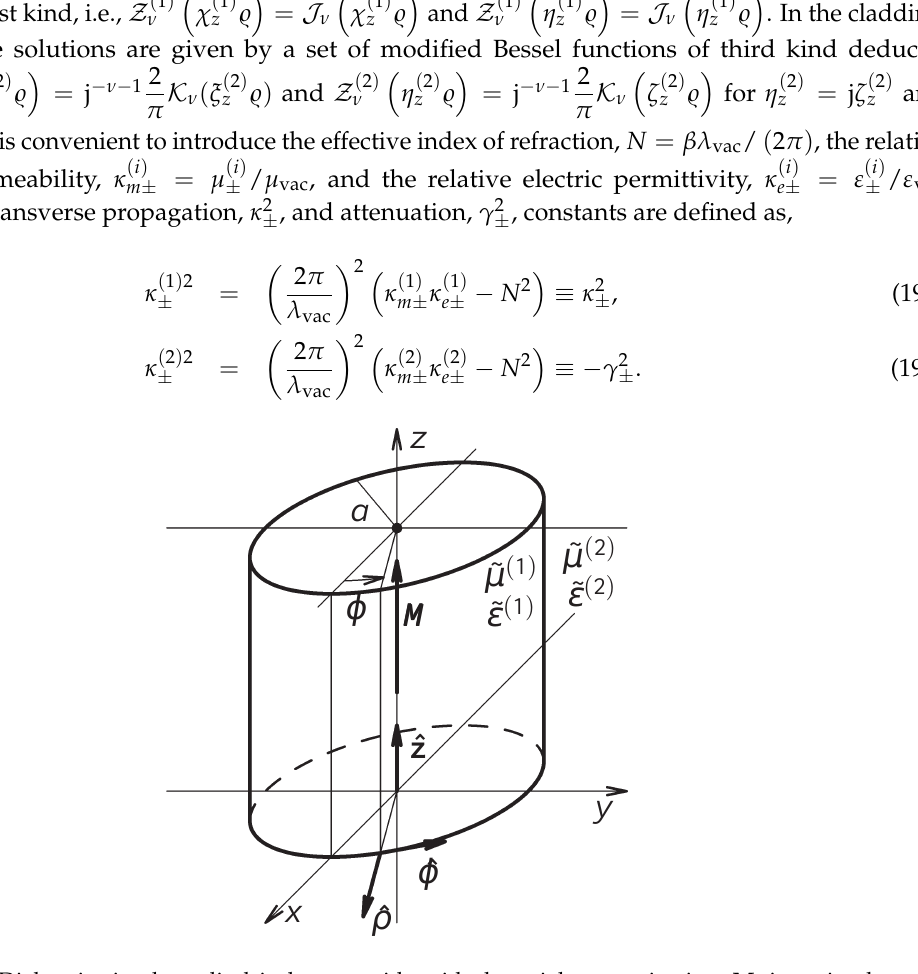
x 2 + y 2 , (cid:112)